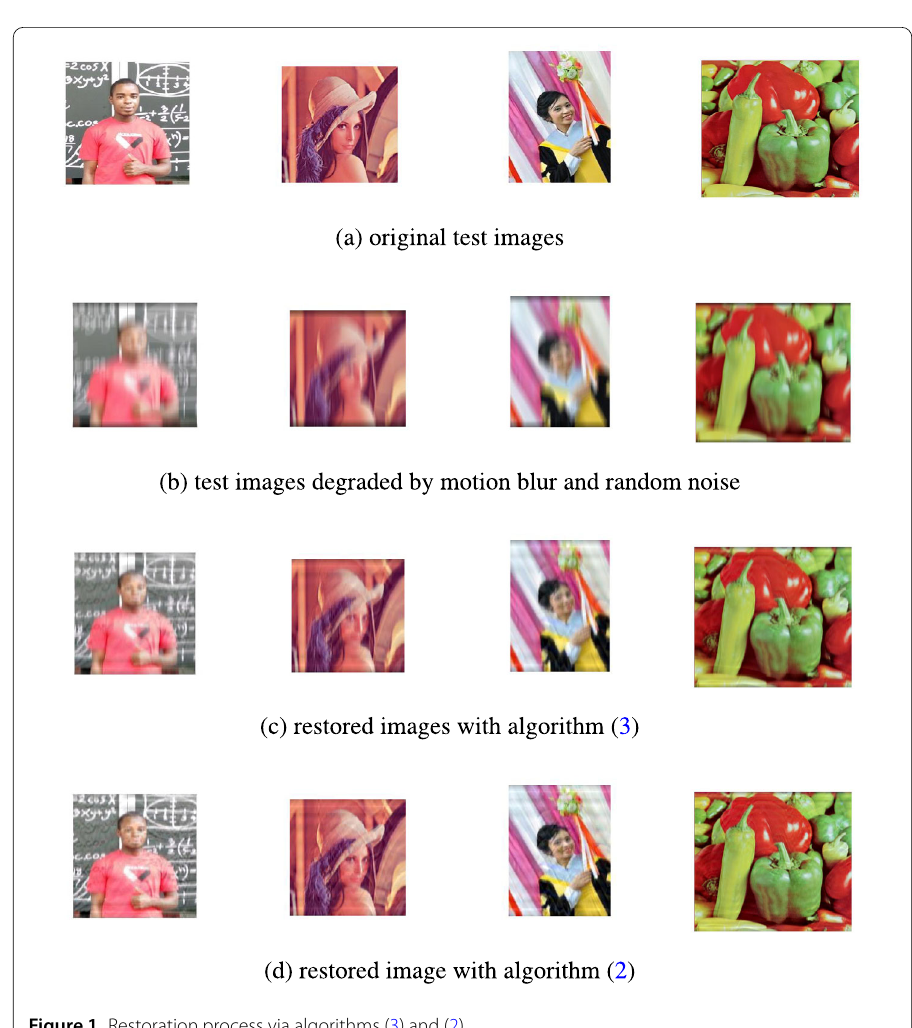
–4 and a maximum number